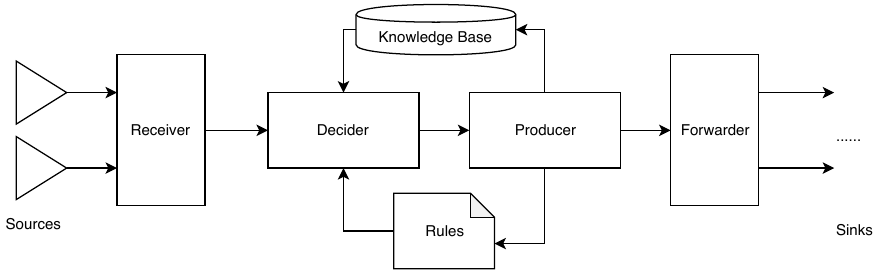
Figure 4. Information flow processing schema, adopted from